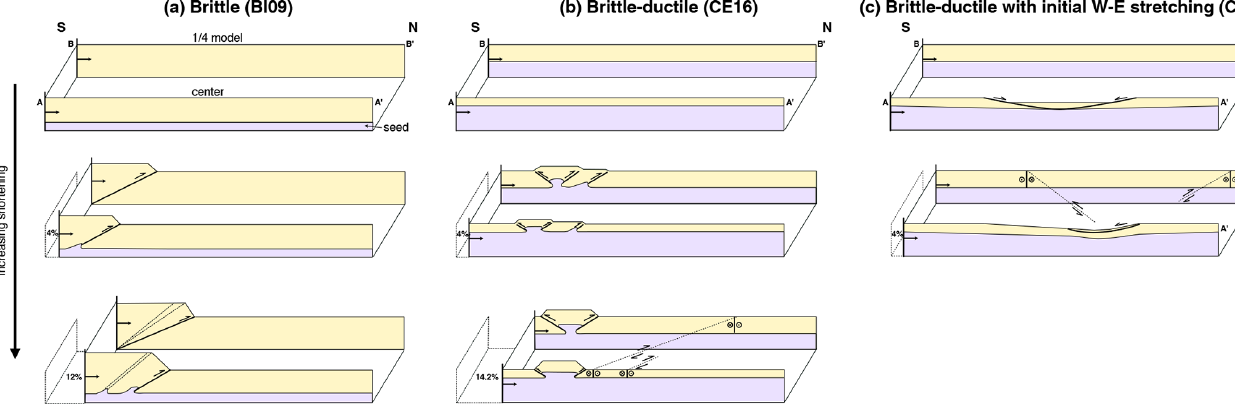
Figure 10. N–S cross-sections interpreted from top pictures before deformation (top row), after 4% of shortening (central row) and after 12% to 14% of shortening (bottom row) for models with (a) a brittle crust (BI09), (b) a brittle–ductile crust (CE16), and (c) a brittle–ductile crust and two-stage deformation (CE17). The three models share comparable ratios of stretching over shortening rates V e /V s = 0 . 9. For each model, section AA’ corresponds to the center of the model where the seed is located and B-B’ to the western quarter of the model. The brittle layer is indicated in yellow and the ductile layer in